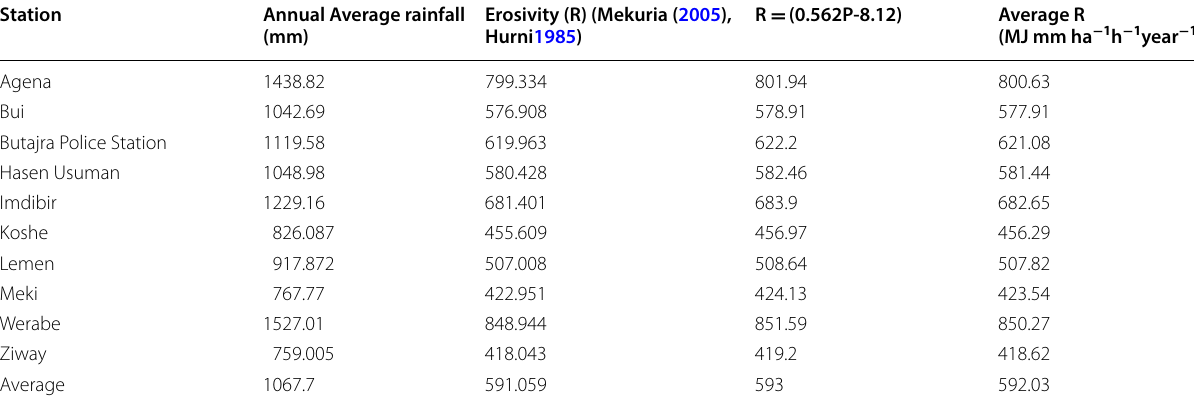
Table 2 Rainfall erosivity interpolation